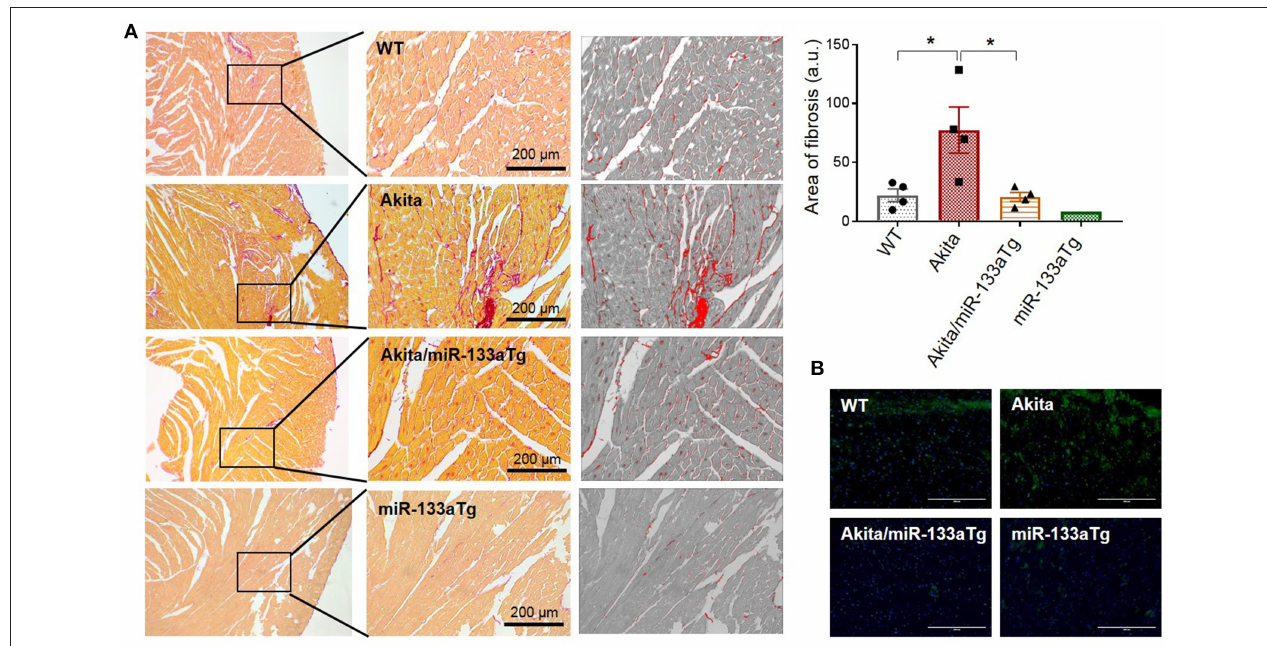
FIGURE 4 | Cardiac-specific miR-133a prevents DM-induced cardiac fibrosis. (A) Picrosirius red staining of the heart from WT, Akita, Akita/miR-133aTg, and miR-133aTg mice. Values are presented as mean ± SEM. One-way analysis of variance (ANOVA) followed by Tukey’s test was used for statistical significance. N = 4 per group. * P < 0.05. (B) In situ zymography for collagenase activity was performed on the heart sections of WT, Akita, Akita/miR-133aTg, and miR-133aTg mice. The green fluorescent protein represents cleaved collagen and blue color represents nuclei (DAPI staining). N = 1 per